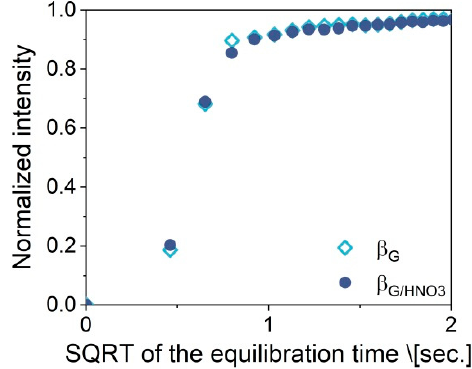
Figure 7. Dependence of the normalized intensity of 1450-cm − 1 band of hexane on the square root of time for zeolites β G/HNO3 and β G . Hexane was sorbed at 100 °C.